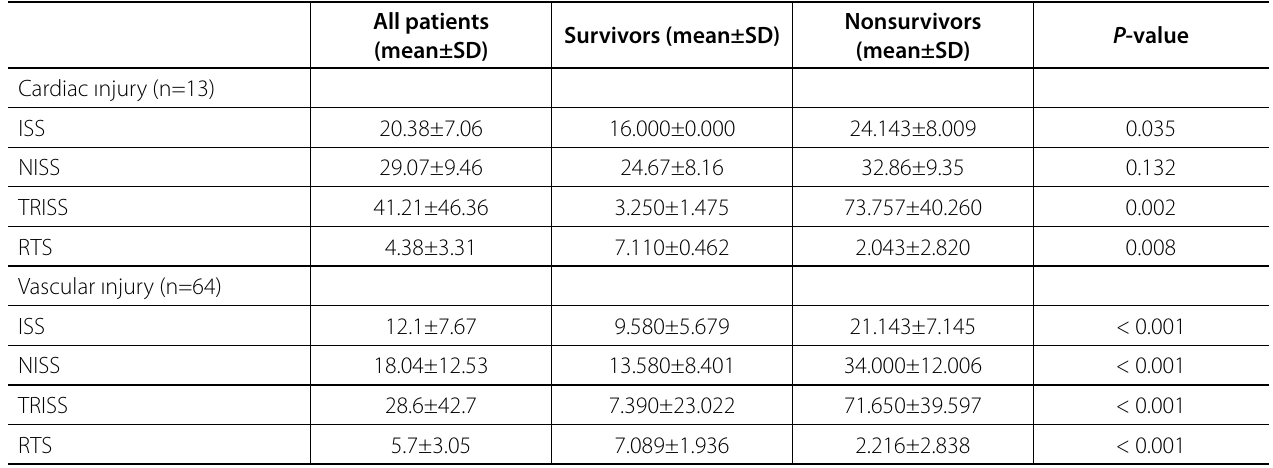
Table 5 . Mean risk scores of patients with cardiac and vascular injuries. All